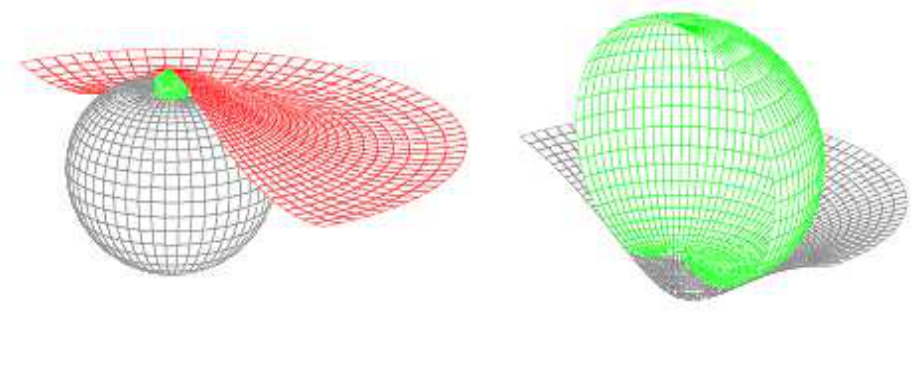
Figure 10. The conjectured densest geodesic ball packing configuration for all Thurston geometries in the specific projective model of S 2 × R geometry whose density is ≈ 0.87757. .